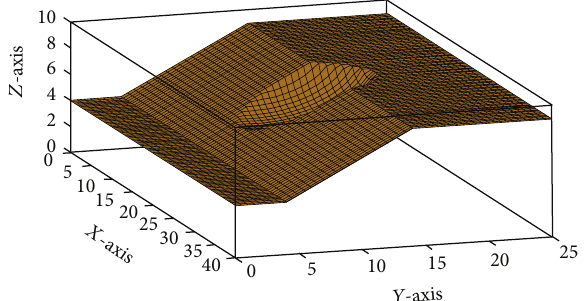
Figure 20: The CSS obtained by the present study in example problem